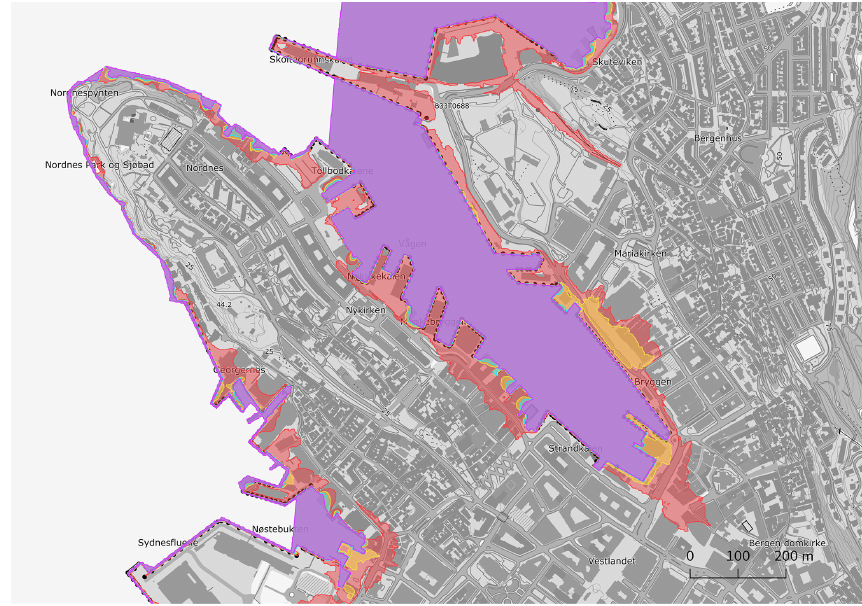
Figure 7. Stack of inundation maps indicating areas affected by coastal flooding in Bergen. Violet: present MHW. Green: MHW at 2090 (0.71m above present MHW). Orange: present 200-year storm surge (0.96m above present MHW). Red: 200-year storm surge for 2090 (1.68m above present MHW). Map data shown are provided by Geonorge and Norway Digital consortium and subject to the Norwegian License for Open Government Data (NLOD) 2.0 and Creative Commons BY 4.0 (CC BY